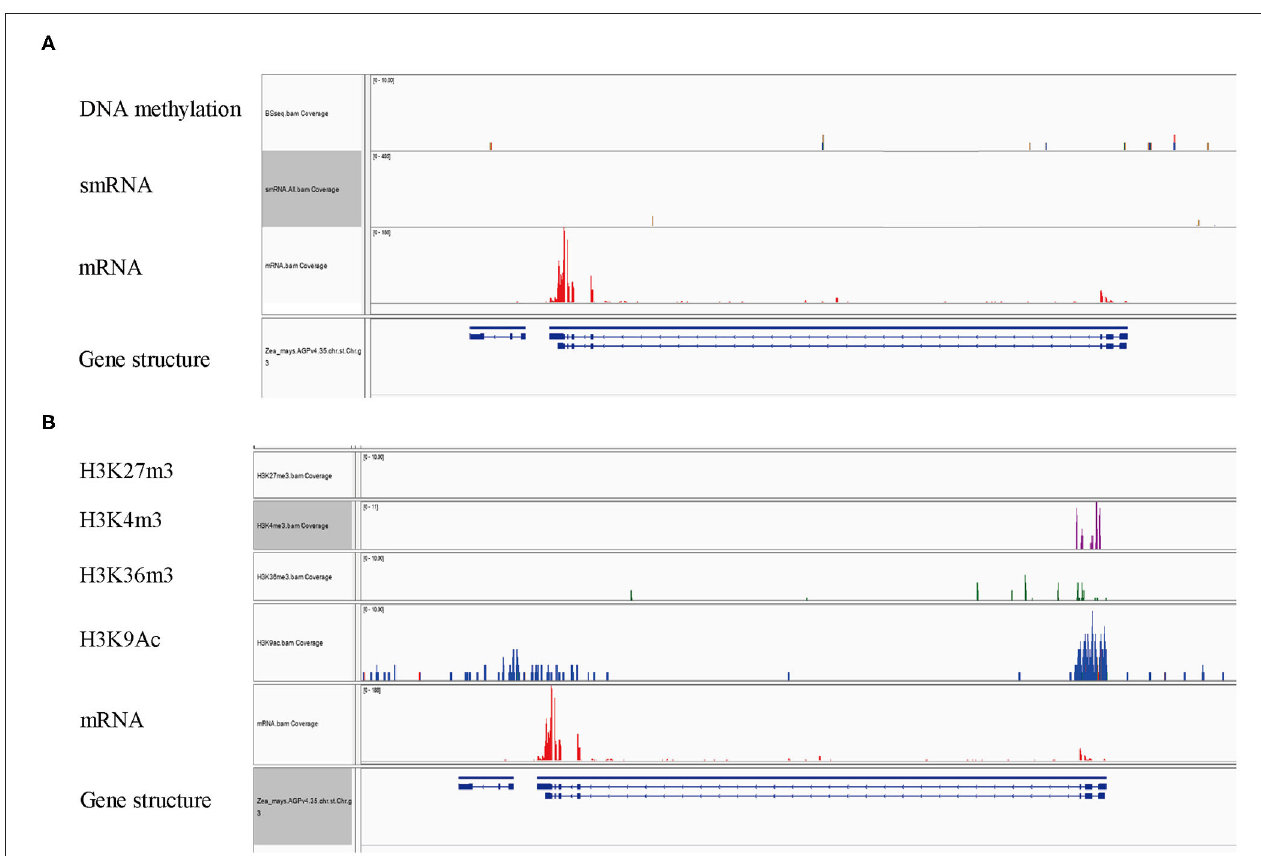
FIGURE 7 | Epigenetic modifications associated with ZmFdC2 locus. (A) , Reads of DNA methylation, mRNA and small RNA on ZmFdC2 locus. (B) , Enrichments of four histone modifications on ZmFdC2 locus. RNA-seq and all epigenetic data were generated from the same samples and downloaded from the publication (Wang et al., 2009